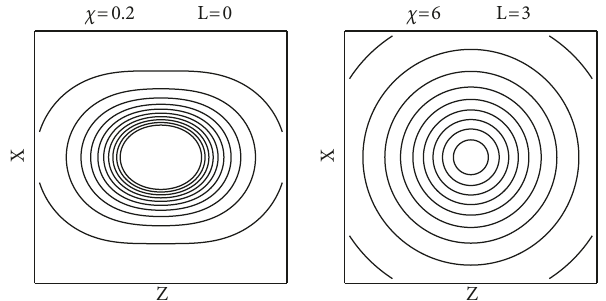
Figure 2: Equipotential contours of the effective potential 𝑉(𝑥,𝑧) at 𝑦 = 0.5 , as given by Eq. (15). Dipole along 𝑧 -axis. Far from center the isopotential surfaces are deformed